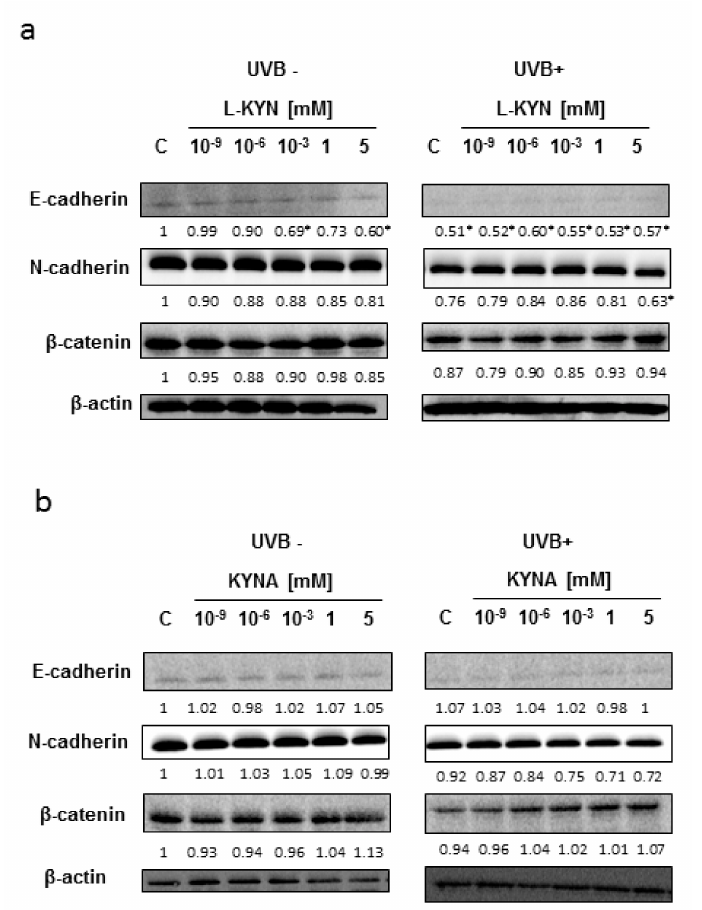
Figure 3. The effect of UVB on E-cadherin, N-cadherin, and β -catenin levels in melanoma SK-MEL-3 cells exposed to KYN ( a ) and KYNA ( b ). Melanoma SK-MEL-3 cells were exposed to UVB (UVB+) and then to culture medium (control, C) or serial dilutions of KYN and KYNA (10 − 9 , 10 − 6 , 10 − 3 , 1, and 5 mM). Similarly, the biological activity of KYN and KYNA was studied in melanoma cells under standard conditions (UVB − ). The effect of UVB and tested substances on the protein level of selected proteins involved in adhesion and migration (E-cadherin, N-cadherin, and β -catenin) was determined by means of Western blot. Western blots were selected as the most representative of the series of repetitions. UVB − and UVB+ bands represent the same blot. The results of densitometric analysis, normalized relative to β -actin, are shown as relative value of the control (“*”, the fold changes in protein expression ≥ 30% were considered significant; qualitative